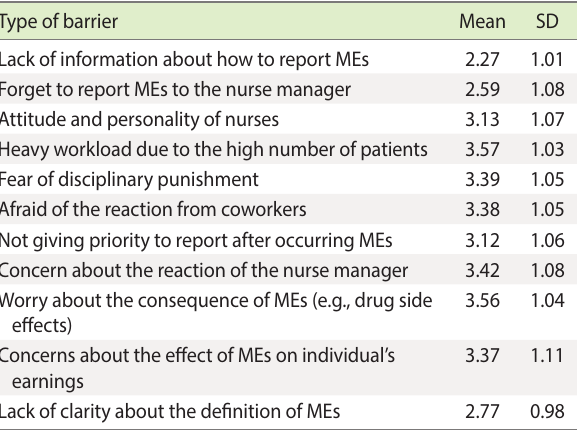
Table 3. Nurses’ assessments of the main barriers to reporting MEs in Kermanshah, western Iran, 2016 (n=500)